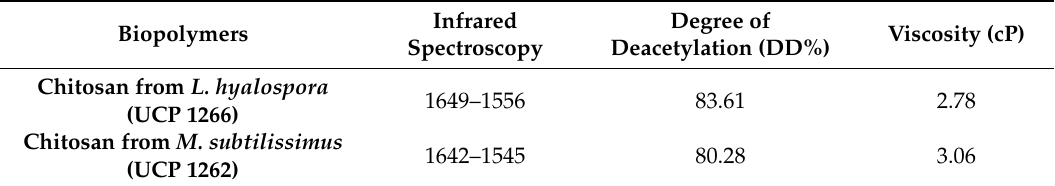
Table 5. Infrared spectroscopy, degree of deacetylation (DD%), and viscosity of chitosan samples produced by Mucor subtilissimus (UCP 1262) and Lichtheimia hyalospora (UCP 1266) in (CWW) and corn steep liquor (CSL).